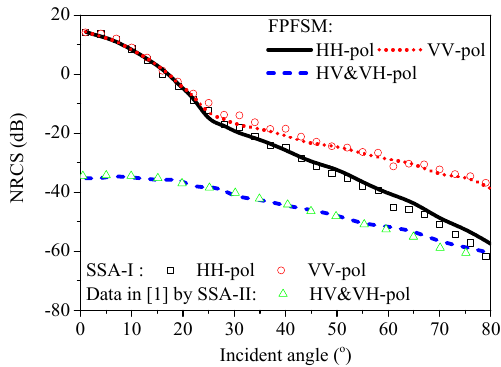
Figure 10. Performance of the FPFSM at Ka-band.